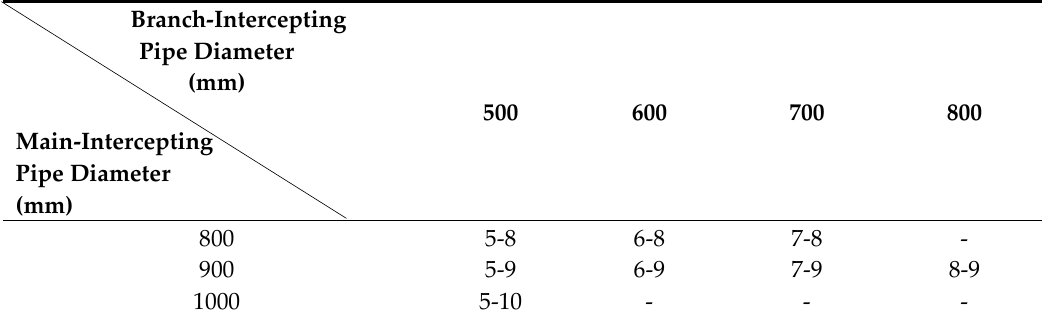
Table 4. Table 4. Combined sewer overflow (CSO) control